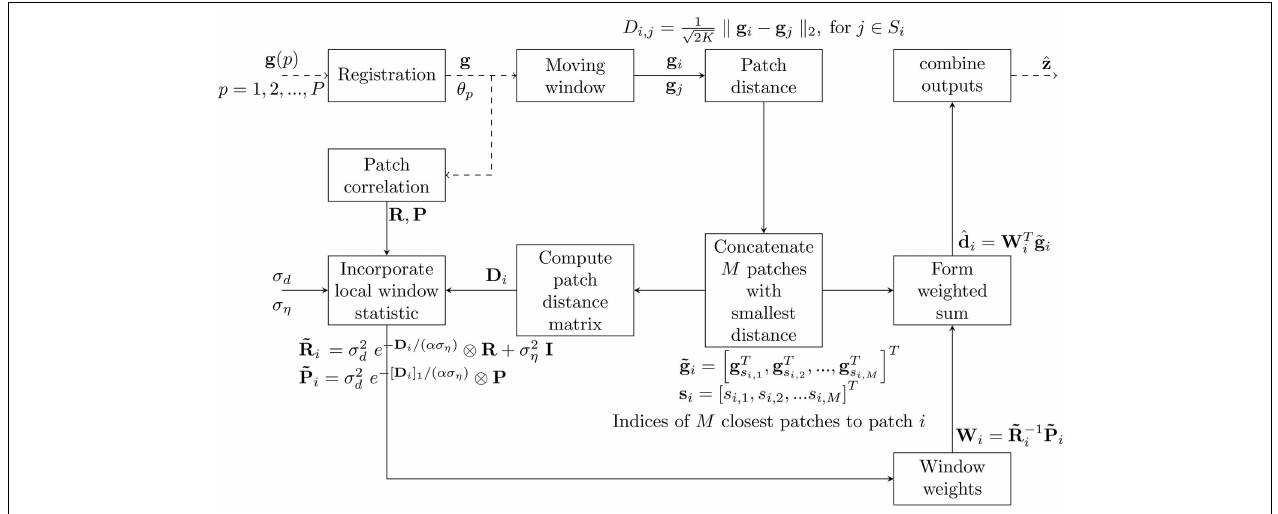
FIGURE 2 | Block diagram illustrates the proposed CAWF SR algorithm. Dashed lines mean the process occurs one time for the entire process while continuous lines mean the process repeats for each moving window ( J times).